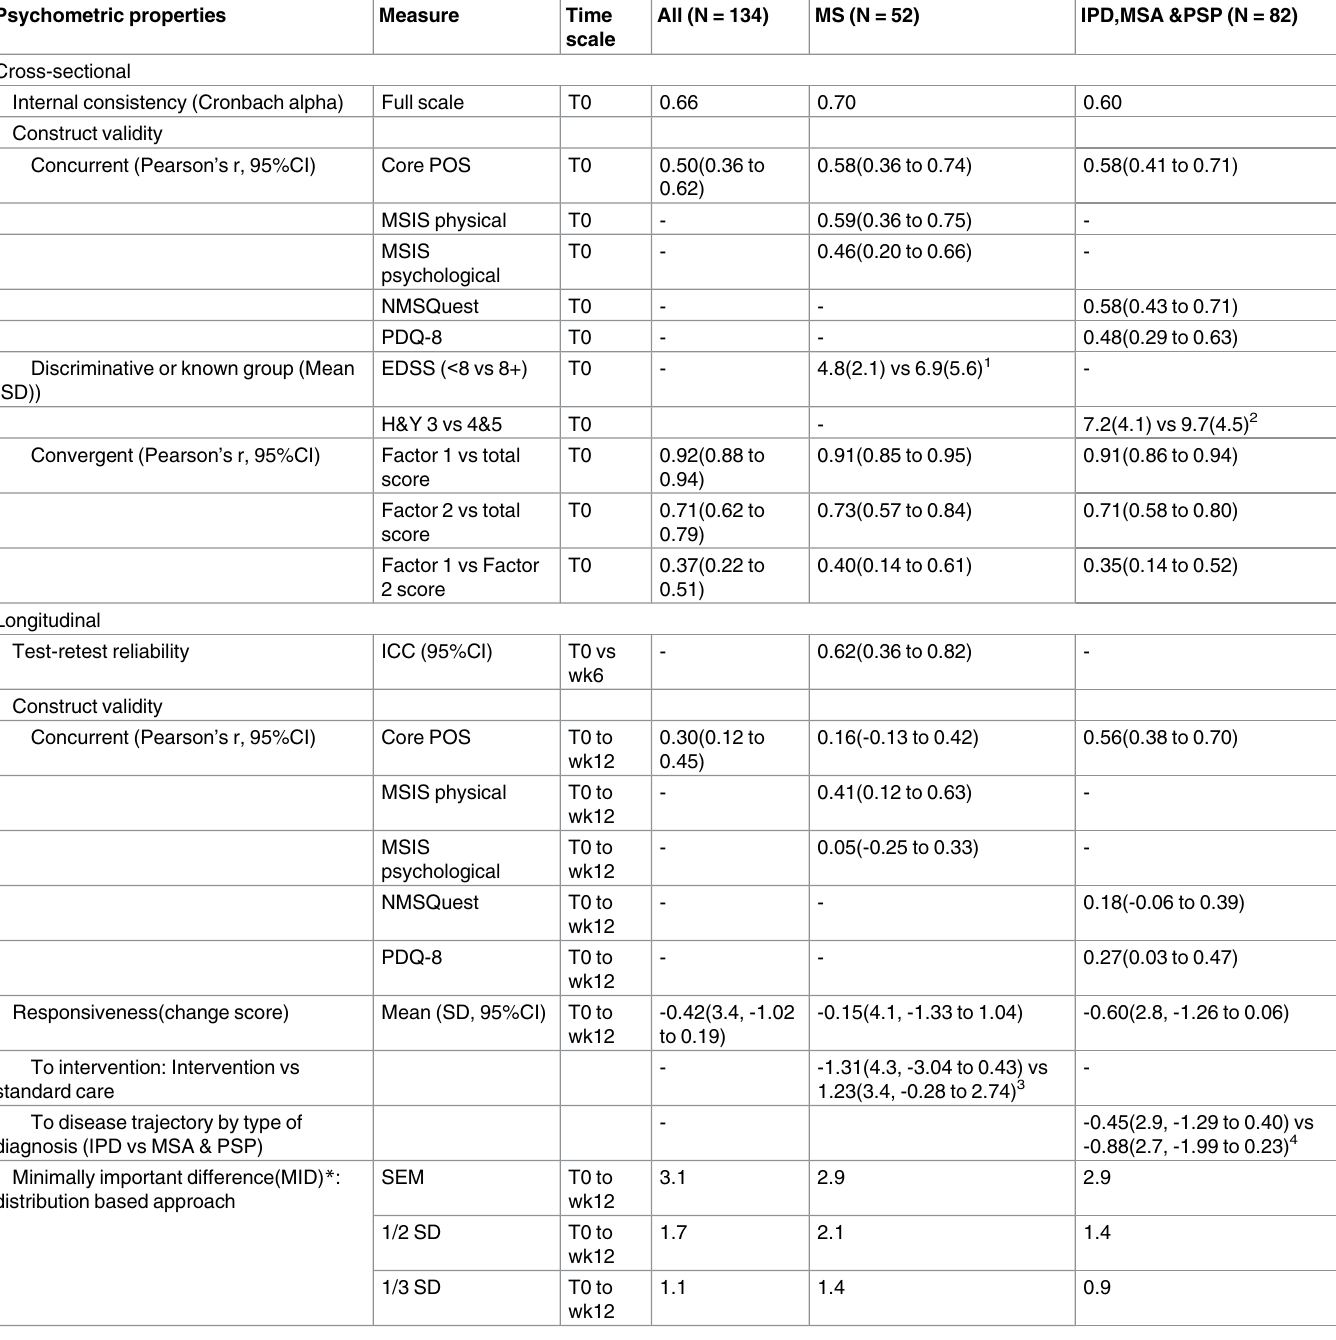
Table 4. Cross-sectional and longitudinal reliability and validity of the IPOS